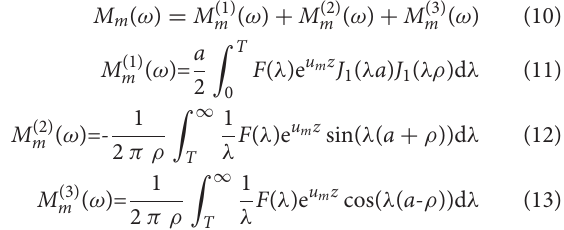
In which, R , L, and C are equivalent resistance, inductance and capacitance of the discharge circuit; and U 0 is the initial charging voltage on the capacitor. The above parameters are known. In order to obtain M m ( t ), the values M m ( ω ) at different frequencies should be calculated with Formula (2). Because the integral kernel contains the product of two Bessel functions and the brain tissue is in millimeter scale, the integral has the property of high oscillation and slow convergence, so it is difficult to calculate